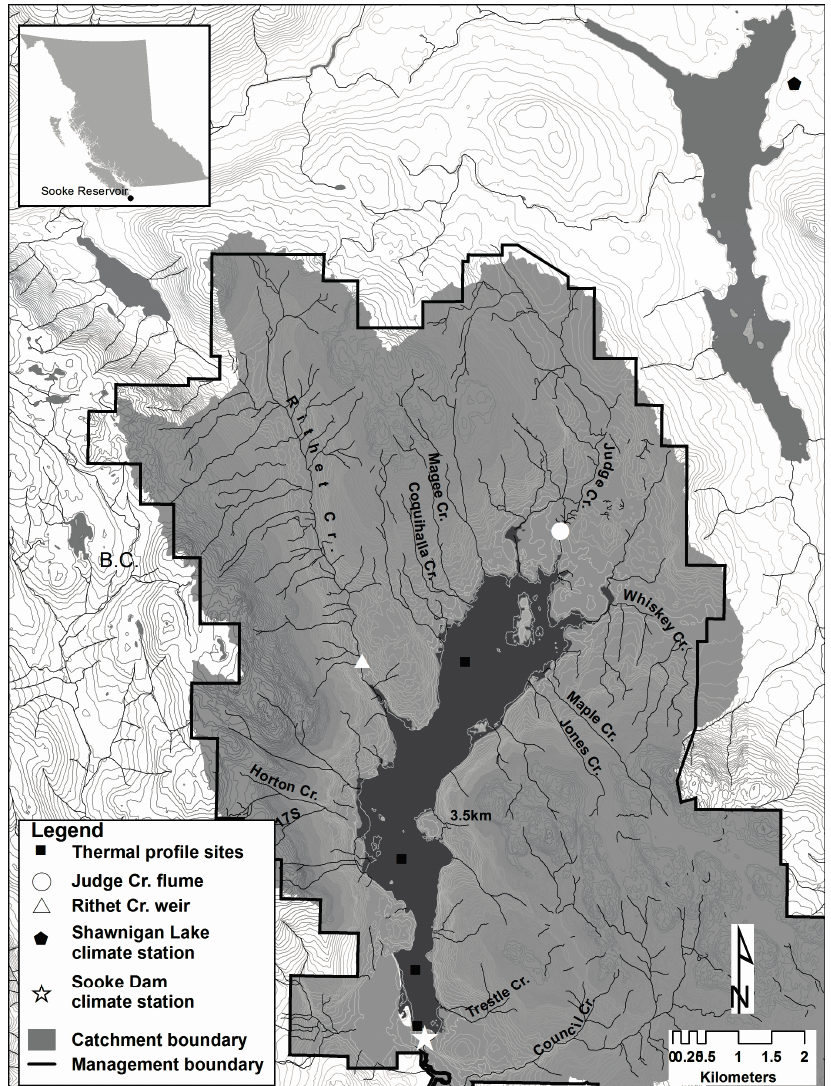
Figure 1. Sooke Reservoir study